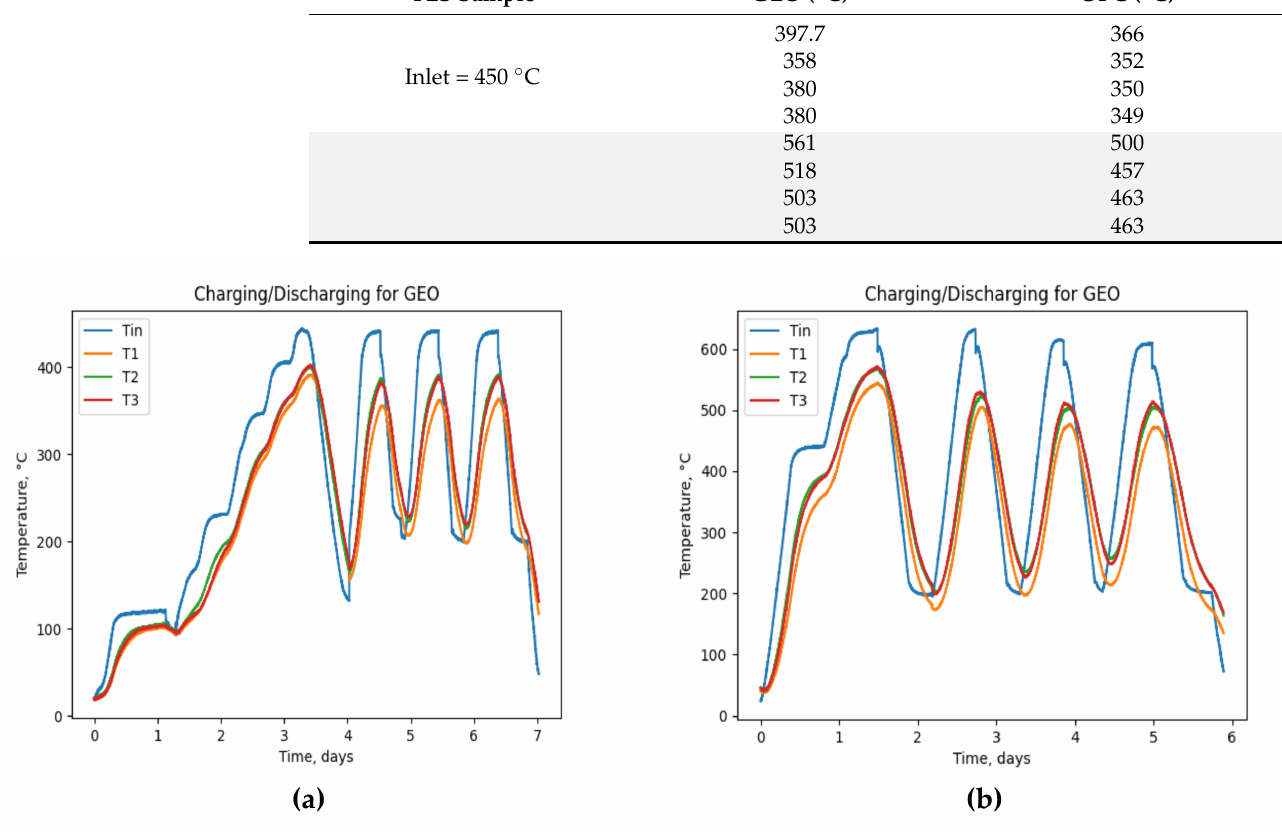
Figure 4. GEO concrete. ( a ) Low-temperature cycles (the temperature of the inlet varying from 200 ± 25 ◦ C to 400 ± 25 ◦ C); ( b ) high-temperature cycles (the temperature of the inlet varying from 200 ± 25 ◦ C to 600 ± 25 ◦ C). T1,T2, and T3 are thermocouples shown in Figure 1. Tin is the HTF (air) inlet